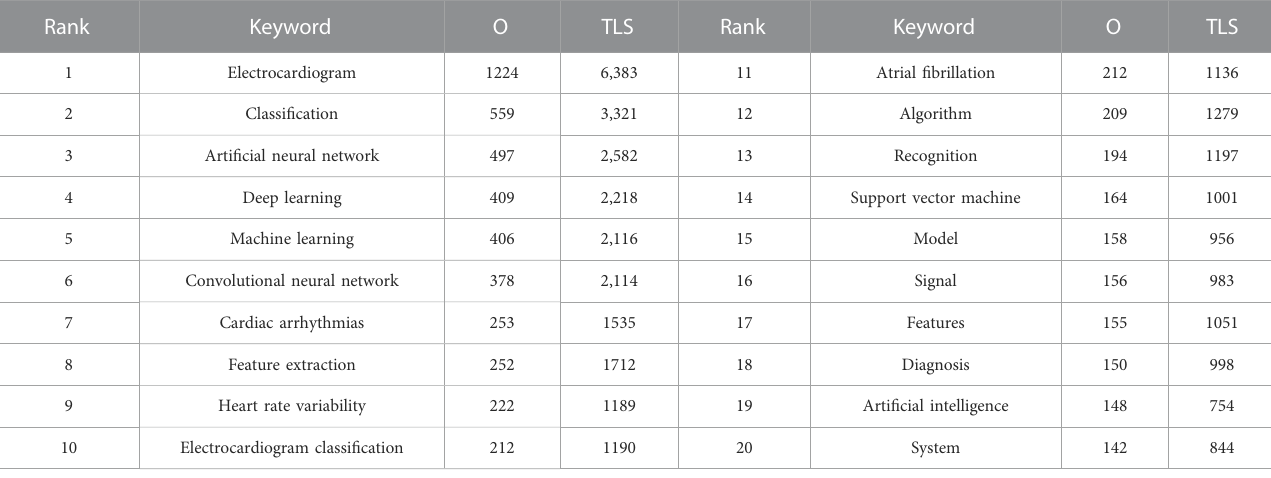
TABLE 7 Top 20 co-occurrence keywords.